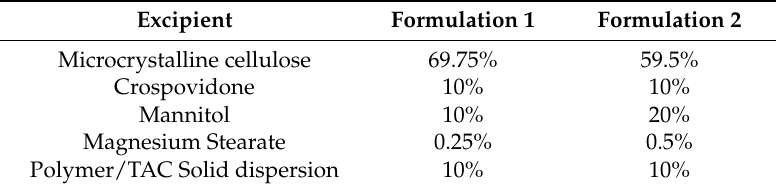
Table 2. Composition of orally-disintegrating tablets (ODT) formulations.